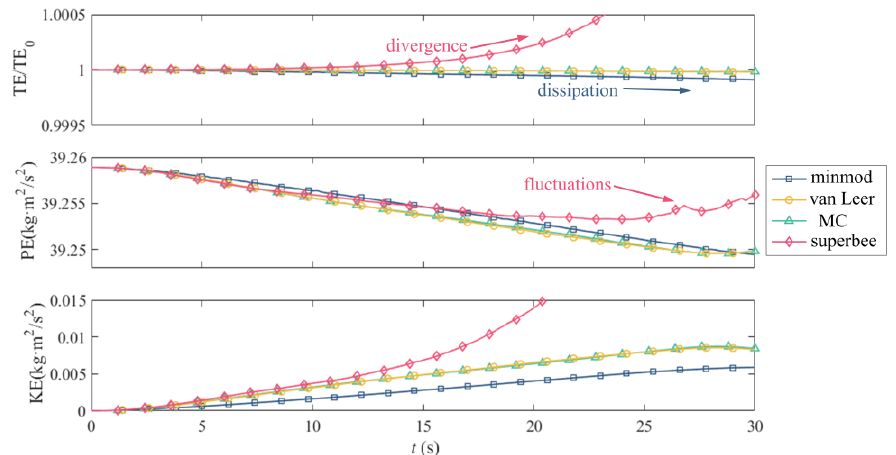
Figure 14. Time series of TE/TE 0 , PE, and KE for the inviscid case of the lock-exchange problem with the grid resolution N x × N z = 400 × 100.